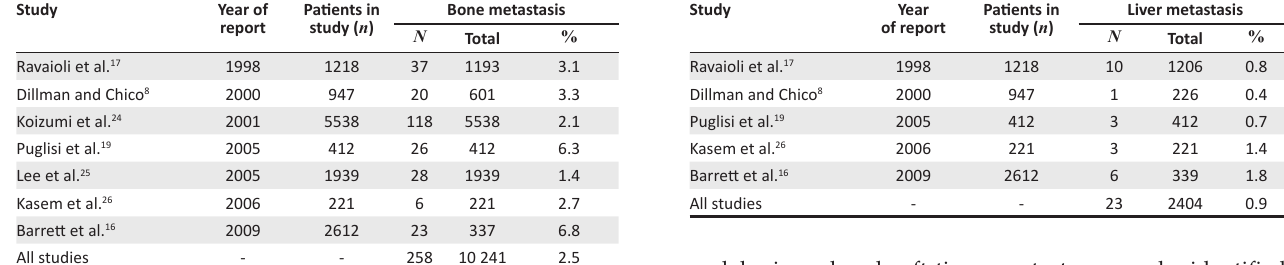
TABLE 3: Prevalence of liver metastasis in all stages of disease, as detected by liver ultrasound. Study Year Patients in of report study ( n )